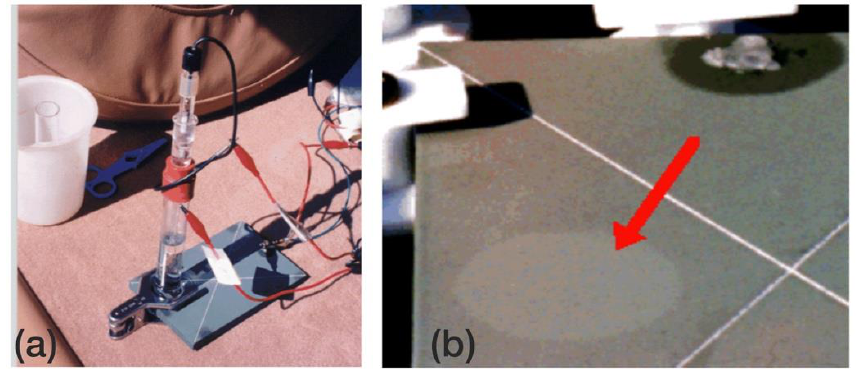
Figure 7. ( a ) Traditional EIS measurement in the field. ( b ) A mark on the coating where a traditional EIS cell was attached for measurement in the field [75].